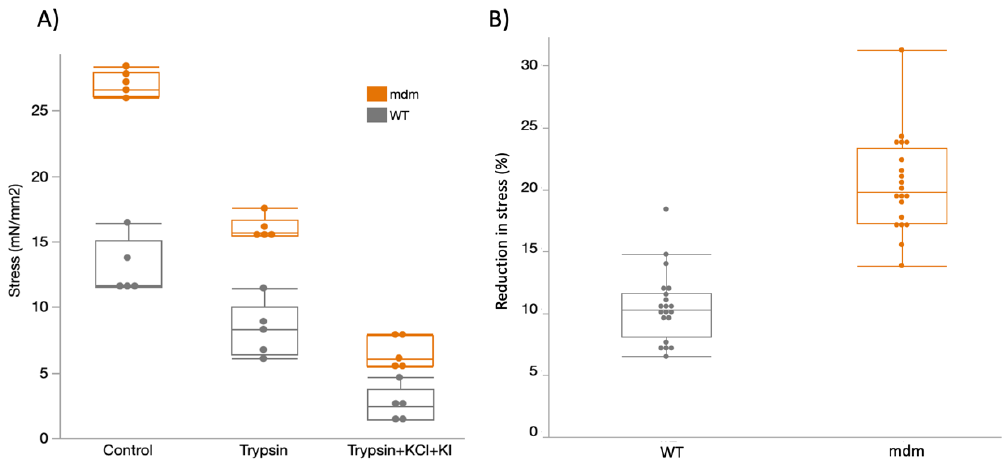
Figure 6. ( A ) Passive tension of mdm fiber bundles was significantly higher than WT for untreated control (ANOVA; F = 131.6; p < 0.0001), trypsin-treated (ANOVA; F = 45.5; p < 0.0001), and trypsin + KCl + KI-treated (ANOVA; F = 22.7; p = 0.0014) fiber bundles. Passive tension decreased significantly from control to trypsin-treated fiber bundles in both WT and mdm (ANOVA; F = 419.7; p < 0.0001). In addition, there was a significant decrease in passive tension after trypsin + KCl + KI in both WT (ANOVA; F = 142.82; p < 0.0001) and mdm fiber bundles (ANOVA; F = 29.45; p = 0.0006). All six groups differed significantly from each other (Tukey ’s HSD, p < 0.05). ( B ) Reduction (%) in passive stress after trypsin + KCl + KI treatment was significantly greater in mdm soleus fiber bundles compared to WT (ANOVA; F = 64.1; p < 0.0001), suggesting a higher titin-based passive tension in mdm muscle.